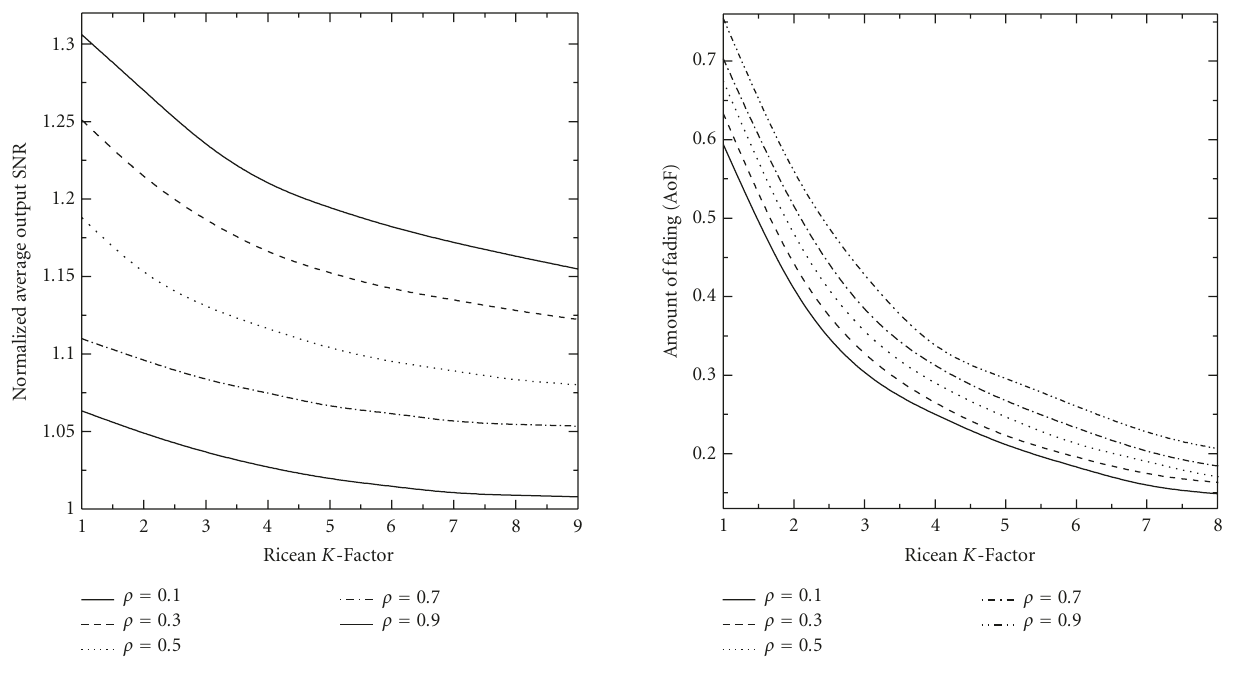
Figure 1: Normalized average output SNR (ASNR) versus the Ricean K -factor for several values of the correlation coe ffi cient ρ .